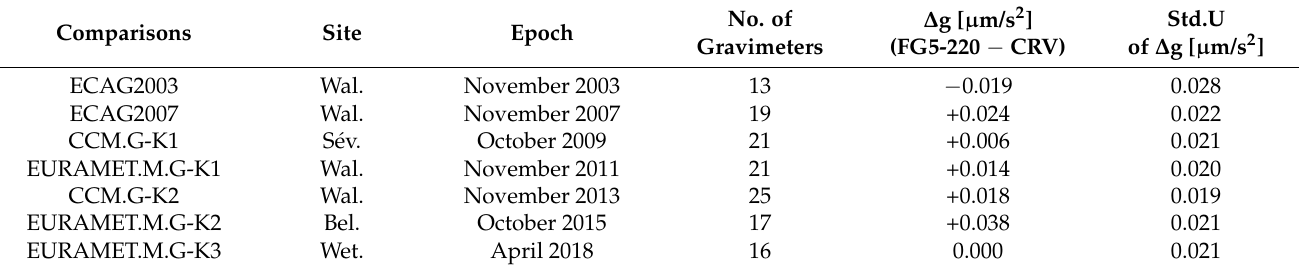
Table 1. Compilation of gravity discrepancies (with standard uncertainties Std.U) between the FG5-220 results and the comparison reference values (CRV). Several European Comparison of Absolute Gravimeters (ECAG) were performed in Walferdange (Wal.), Luxembourg, other comparisons were organized in S é vres (S é v.), France, Belval (Bel.), Luxembourg, and Wettzell (Wet.), Germany. The different CRVs solutions are presented by [23] for ECAG2003, [24] for ECAG2007, and by [25] for the